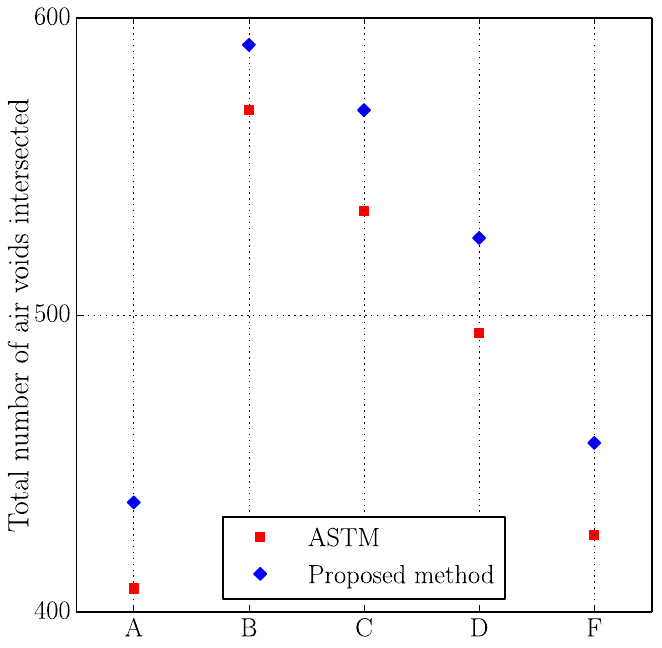
Figure 10. Results of the voids intersected of the slabs studied using the original and the proposed methods.